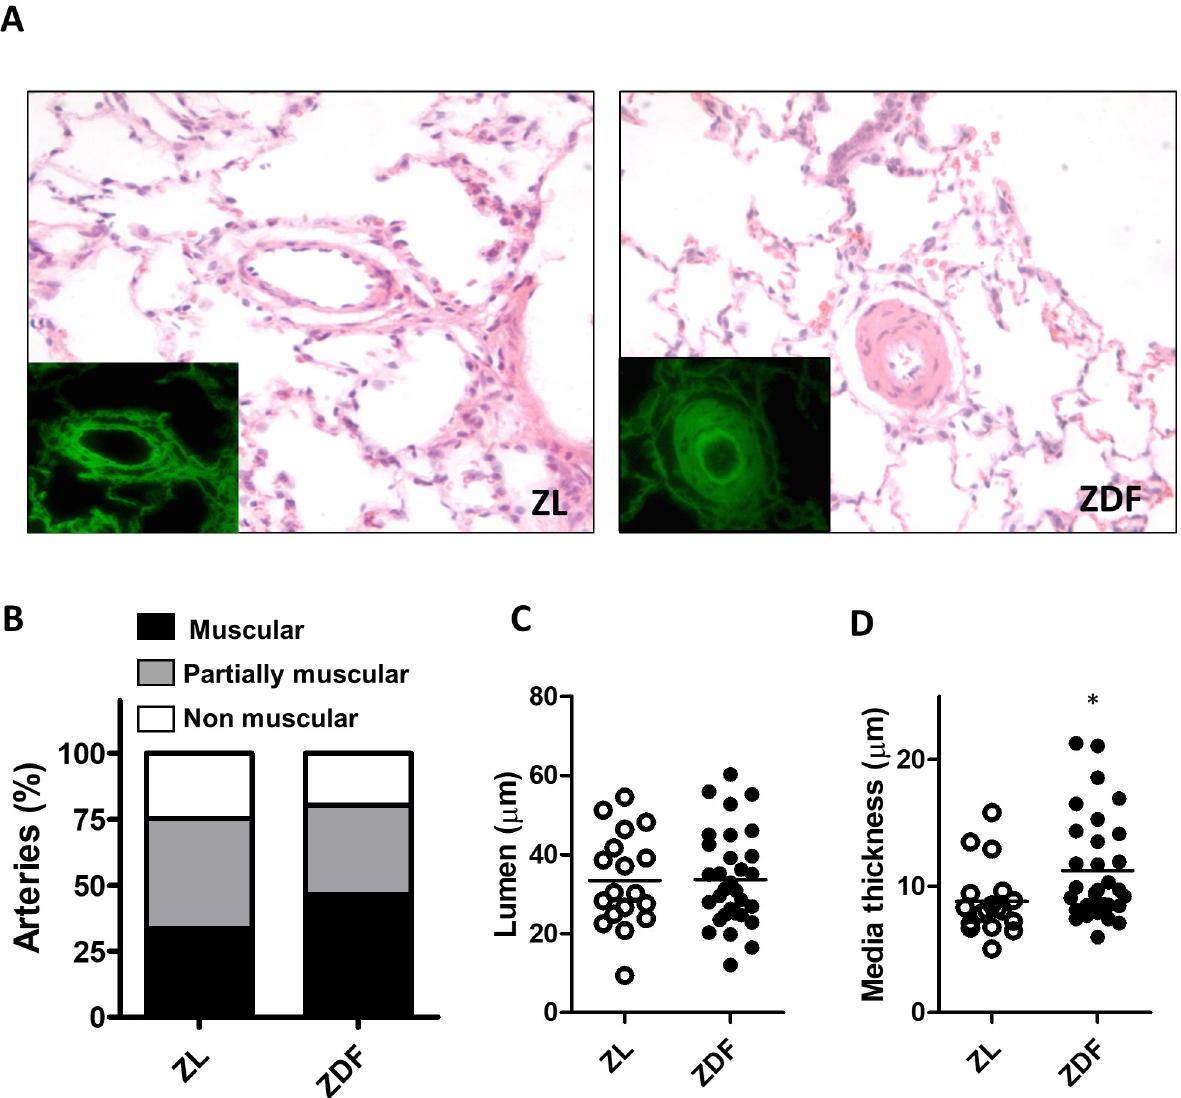
Fig 3. Histological changes in the pulmonary circulation. (A) Representative images of cross-sections of lungs stained with hematoxylin and eosin. On the left a non muscularized small PA from a ZL rat. On the right a muscularized small PA from a ZDF rat. The insets show the green autofluorescence of elastin. (B) Percentage of muscular, partially muscular and non-muscular PA. (C) Lumen and (D) Media wall thickness in PA < 75 μ m. Results are expressed as scatter plots of media thickness in each individual artery from 6 ZL and 6 ZDF rats. � indicates P < 0.05, ZDF versus ZL (unpaired t